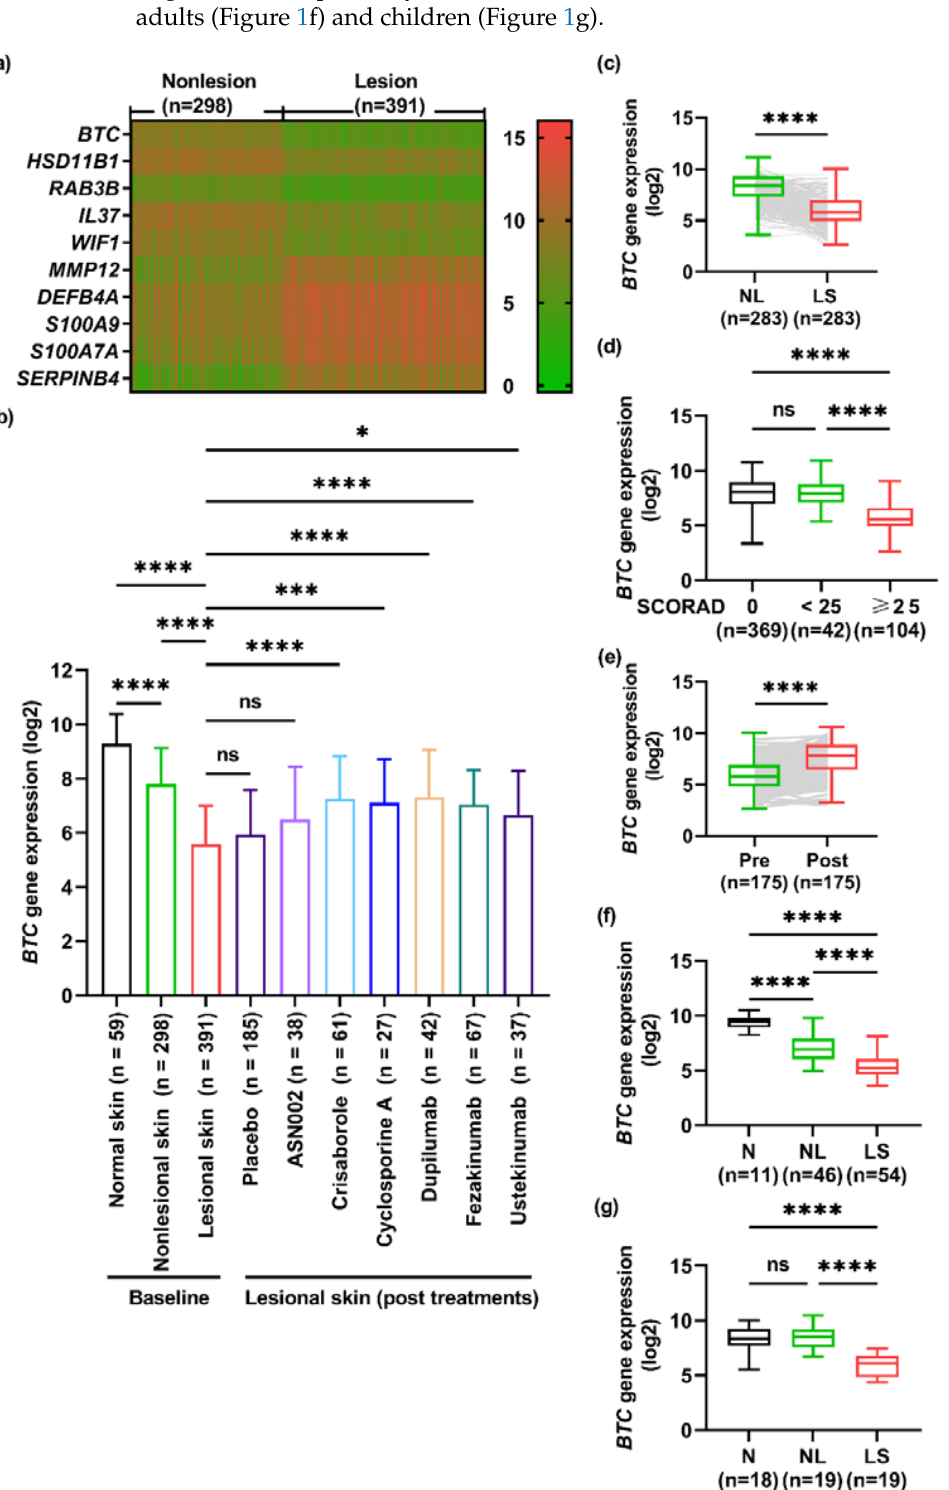
Figure 1. The gene expression of BTC is downregulated in the lesional skin of AD patients. ( a ). Heatmap of the top 10 differentially expressed genes between nonlesional and lesional human AD skin tissues. ( b ). The mRNA level of BTC was markedly decreased in the skin lesions of patients with AD ( n = 391) compared with nonlesional AD skin tissues ( n = 298) and normal